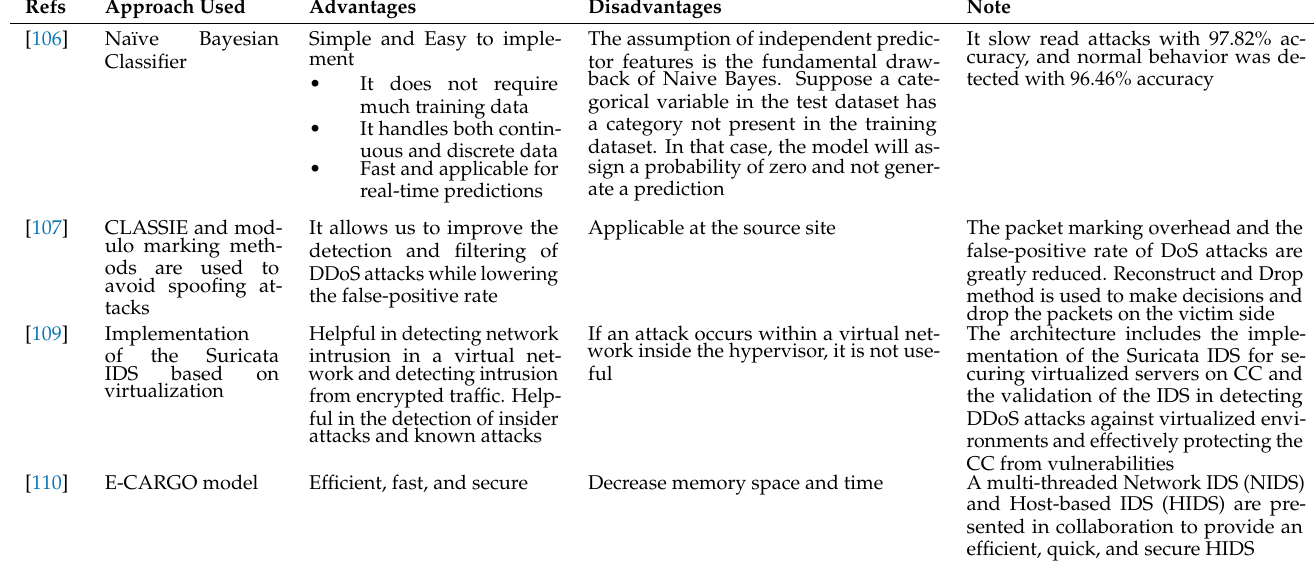
Table 9. Detection approaches based on signature.